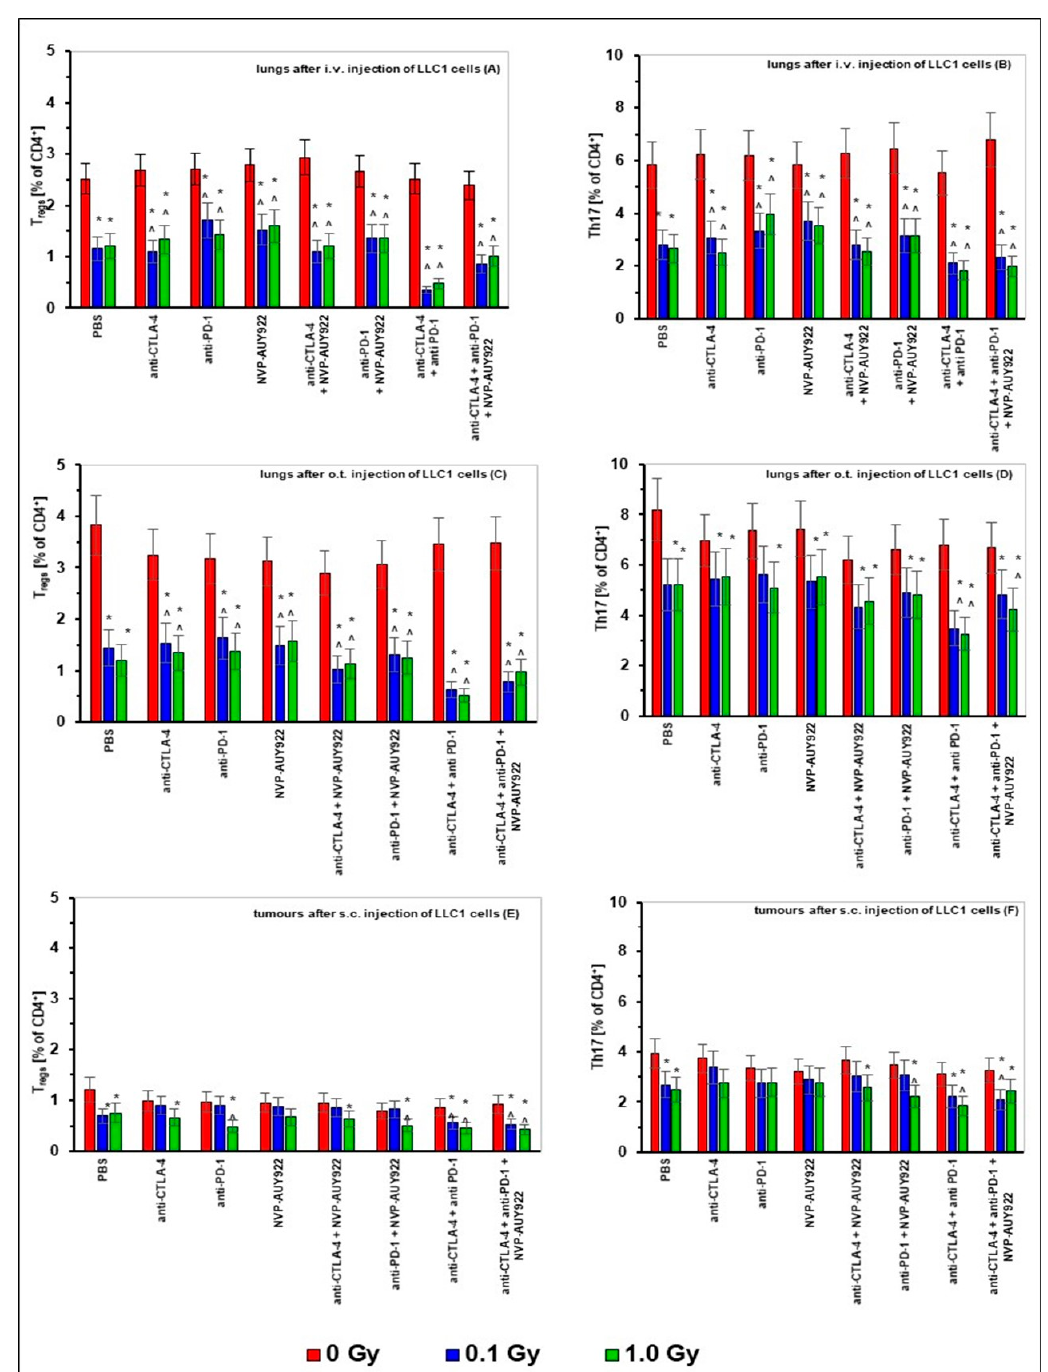
Figure 6. The percentages of regulatory T lymphocytes (Tregs) (panels A , C , E ) and helper T lymphocytes (Th17 cells) (panels B , D , F ) in the lungs after i.v. (panels A , B ) or o.t. (panels C , D ) injection with LLC1 cells or in tumors after s.c. (panels E , F ) injection of LLC1 cells to C57BL/6 mice treated with blockers of the immune checkpoints and/or HSP90 combined with WBI at total doses of 0.1 and 1.0 Gy. The bars formed from mean values of the Tregs and Th17 cells measured in 6 (i.v. and o.t. injection of tumor cells) or 3 (s.c. injection of tumor cells) mice per group are presented. * indicates statistically significant ( p < 0.05) difference from the results obtained in the sham-exposed mice injected with PBS; ^ indicates statistically significant ( p < 0.05) difference from the results obtained in the sham-exposed mice injected with the same molecule or combination of the molecules.